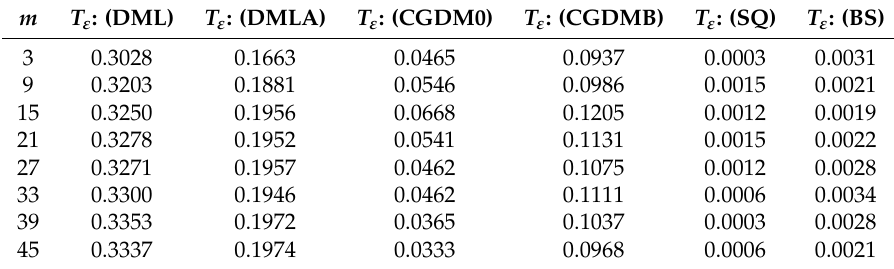
Table 9. Results for Case Q with J = 510, ε = 10 − 2 .